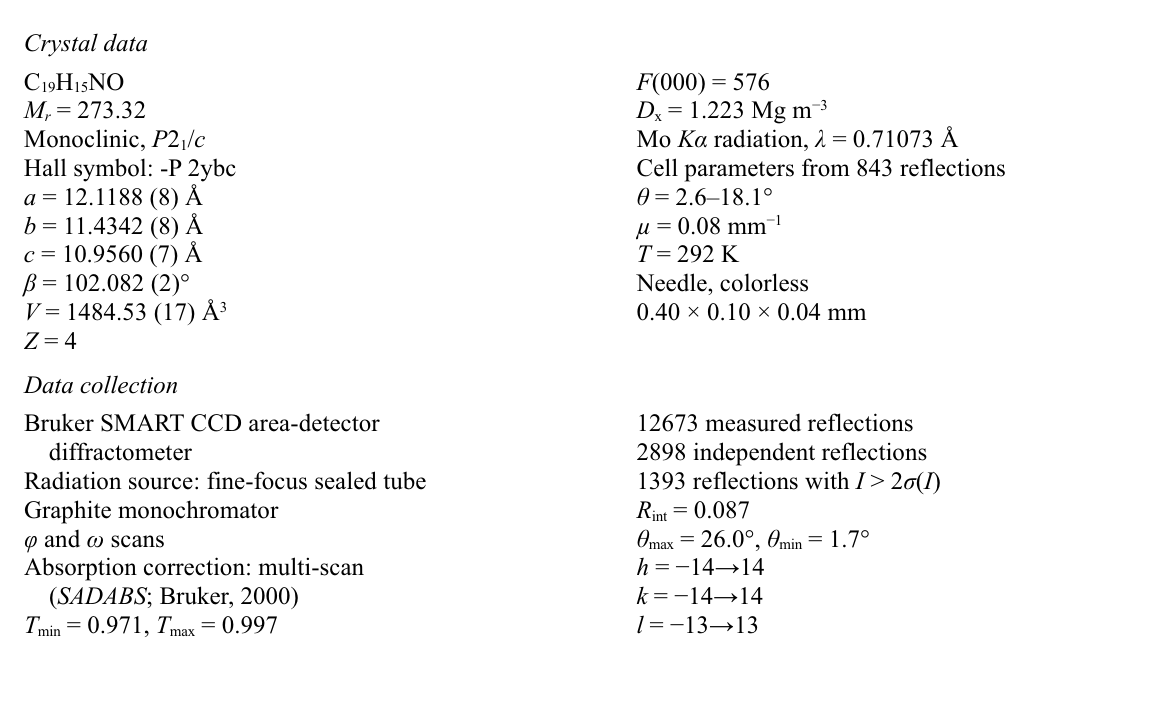
Molecular structure of the title compound showing displacement ellipsoids at 50% probability for non-H atoms.